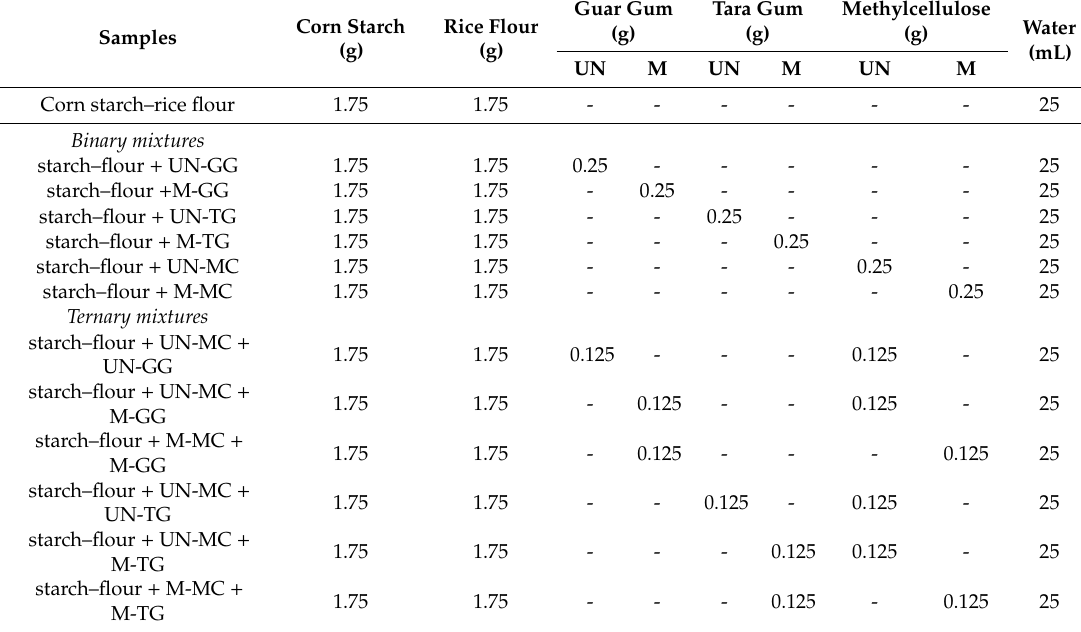
Table 1. Formulations used to prepare the starch / flour-hydrocolloid